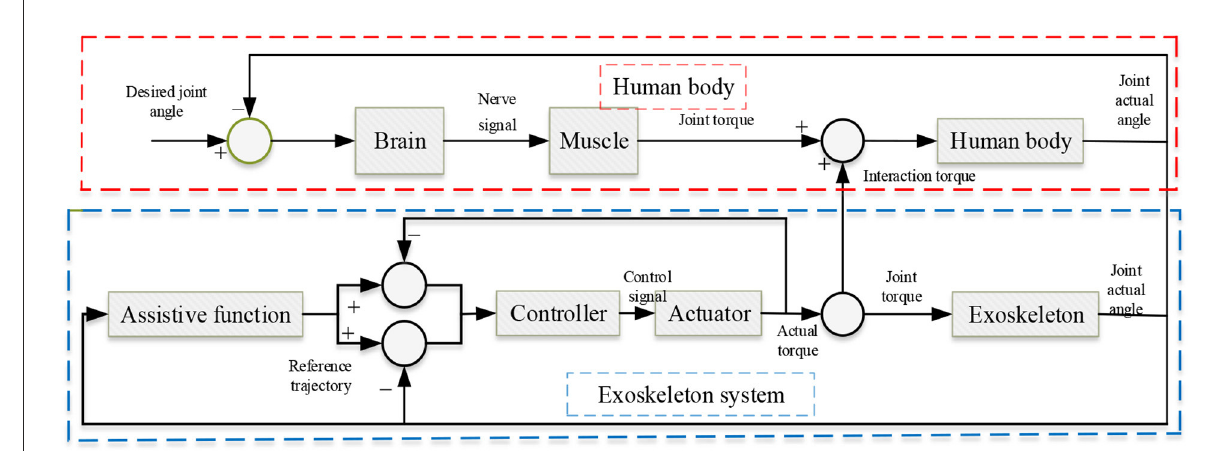
FIGURE5 Structure of conventional human-exoskeleton cooperation (HEC). In the exoskeleton mode section, conventional torque or standard linkage trajectories can be reached based on a determined or predefined supportive function. The desired input torque is connected with the controller to generate control information to drive actuators. The resulting electromagnetic force of the actuator should be utilized or employed to push the user and the exoskeleton. Consequently, the coupling force or energy will be applied to the user’s linkages as additional support for the reference movement. In addition, when the user provides desired movement information, their brain can yield nerve information based on perceptive feedback of the real movement. Finally, users can motivate their muscles to provide or produce joint information data such as force or torque (Chinmilli et al.,